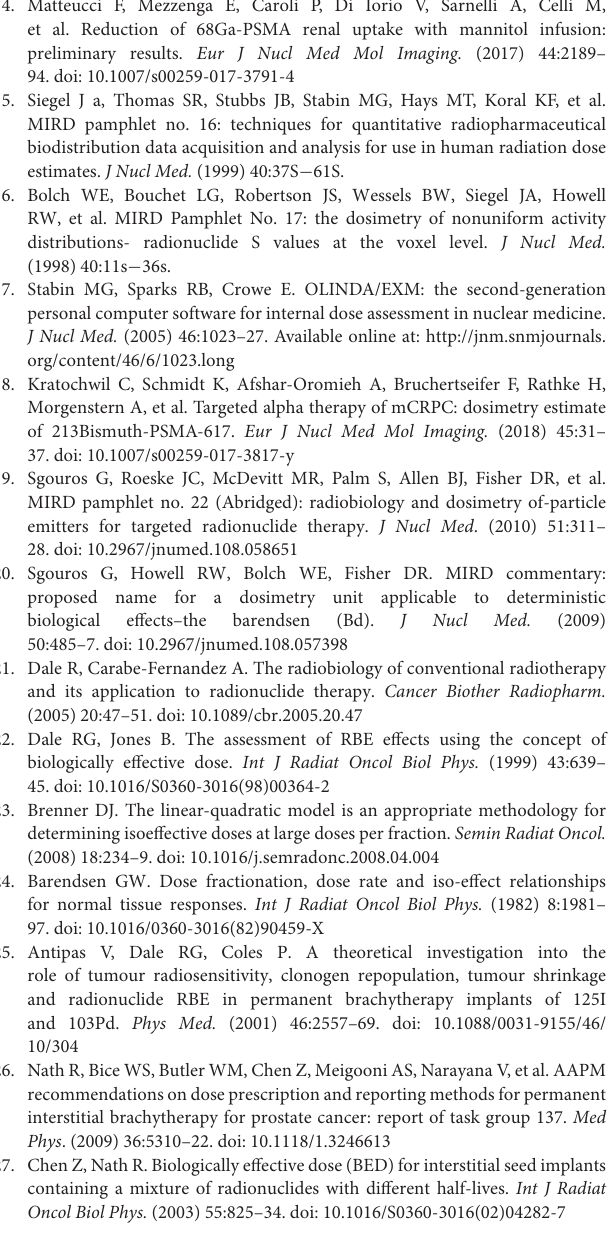
Supplementary Figure 1 | Pre-treatment 68 Ga-PSMA-HBED-11 PET/CT image. The non-uniform uptake distribution inside parotid glands is clearly visible. Supplementary Figure 2 | Cumulative histogram of standard uptake value (SUV) of parotid and submandibular glands. Supplementary Figure 3 | Dose distribution of a head-and-neck cancer patient treated with helical TomoTherapy (66, 60, and 45Gy in 30 fractions). Red contour for 60Gy target, dark-red and cyan contours for right and left PGs respectively. Mean absorbed dose: 25.3, 25.9, 50.6, and 50.1Gy for right and left PGs, right and left SGs respectively. Supplementary Figure 4 | Dose-volume histogram (DVH) of parotid and submandibular